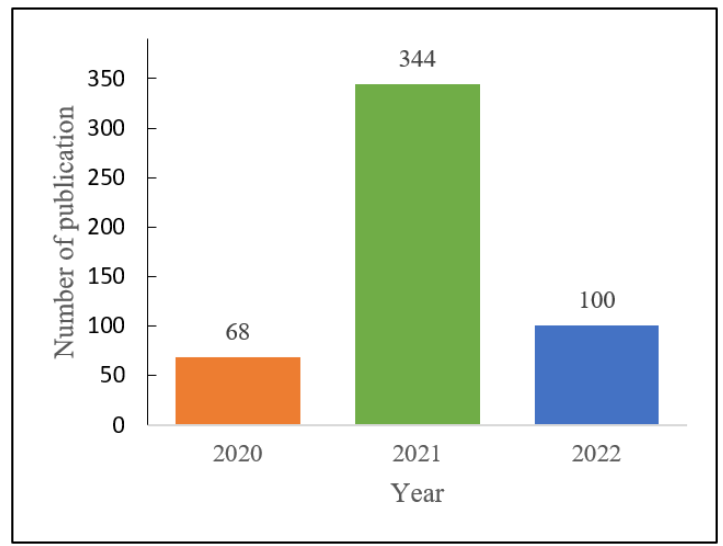
Figure 2. Publication trends of polymer research related to COVID-19.